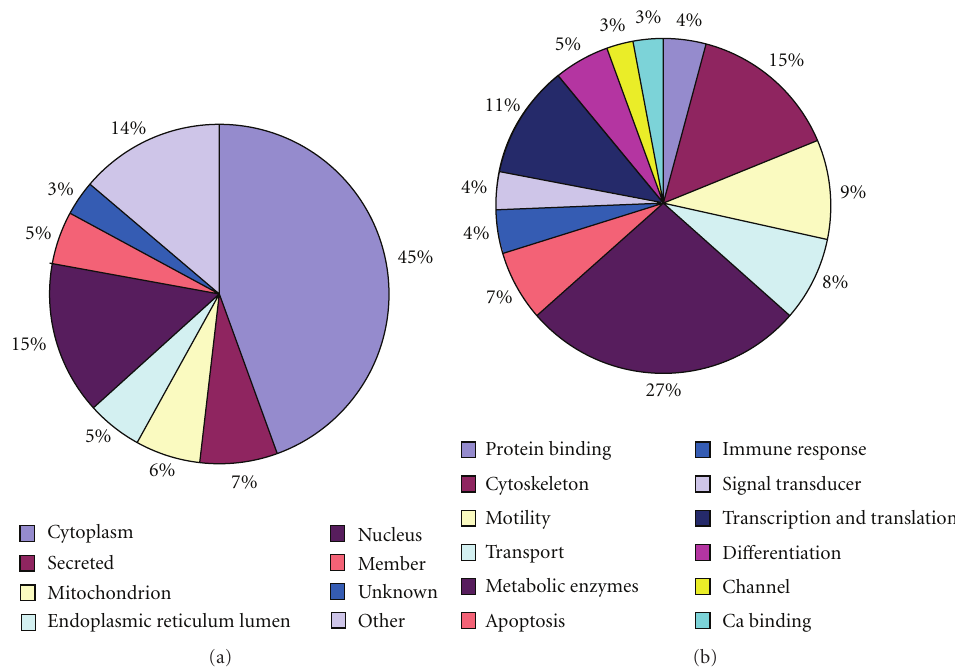
Figure 2: Biological functions and subcellular location of the identified 96 proteins. (a) A pie chart representing the distribution of the identified 96 proteins according to their cellular locations; (b) A pie chart representing the distribution of the identified 96 proteins according to their biological function.